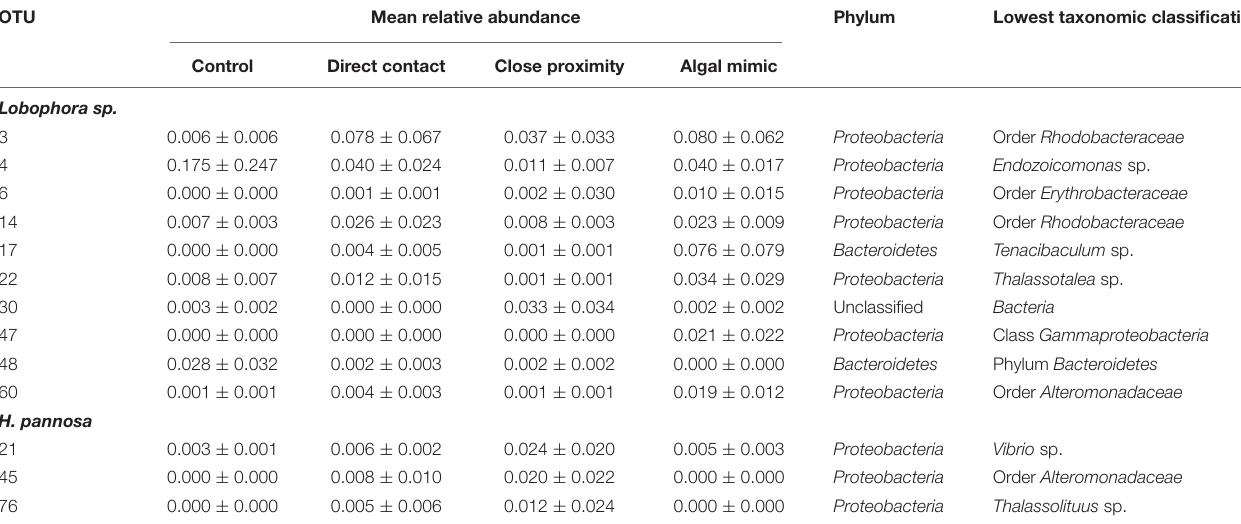
TABLE 3 | Highly abundant ( > 0.01 mean relative abundance of total community ± SD) OTUs identified as contributing significantly to the differences between treatment groups for Montipora stellata interactions with Lobophora sp. and Hypnea pannosa . OTU Mean relative